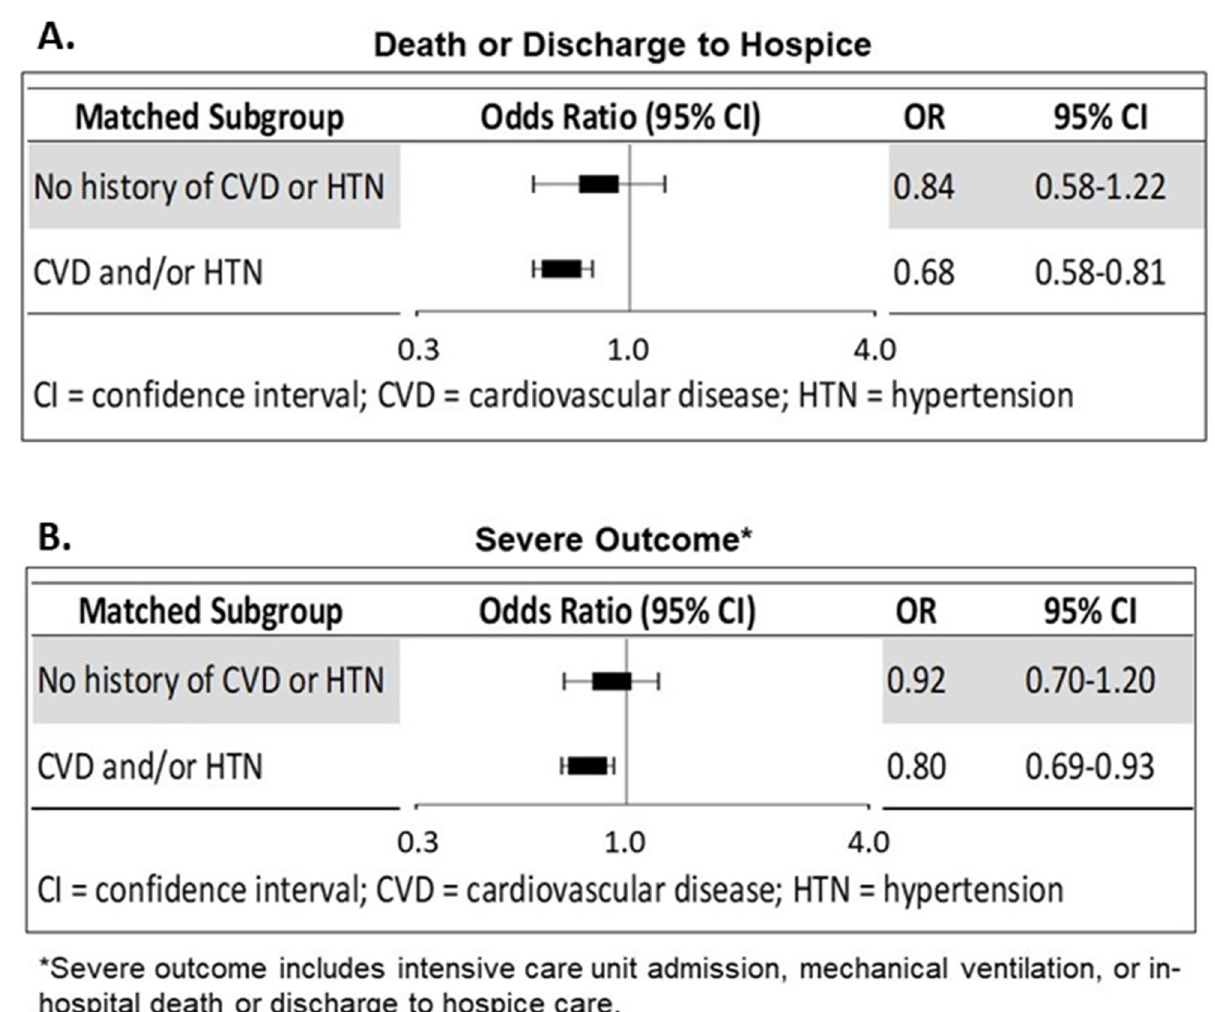
Fig 2. Odds ratios comparing outcomes for users versus non-users of medications. Forest plot showing odds ratio comparing outcomes for those using medication (statin and/or anti-hypertensive) versus not using medication in propensity-score matched samples. for (A) death or discharge to hospice, and (B) severe COVID outcome. Analyses done separately for healthy subjects and for those with a history of cardiovascular disease and/or